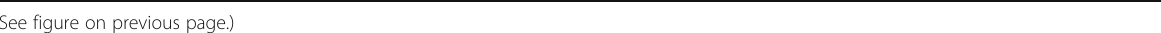
1: Table S1). Most affected species were the Chilean long- tailed snake ( Philodryas chamissonis ; culebra de cola larga) (81.5% of total reptiles), the olive ridley sea turtle ( Lepido- chelys olivacea ; tortuga olivácea) (7.4%) and the Chilean iguana ( Callopistes maculatus ; iguana chilena) (5.6%). Species conservation categories